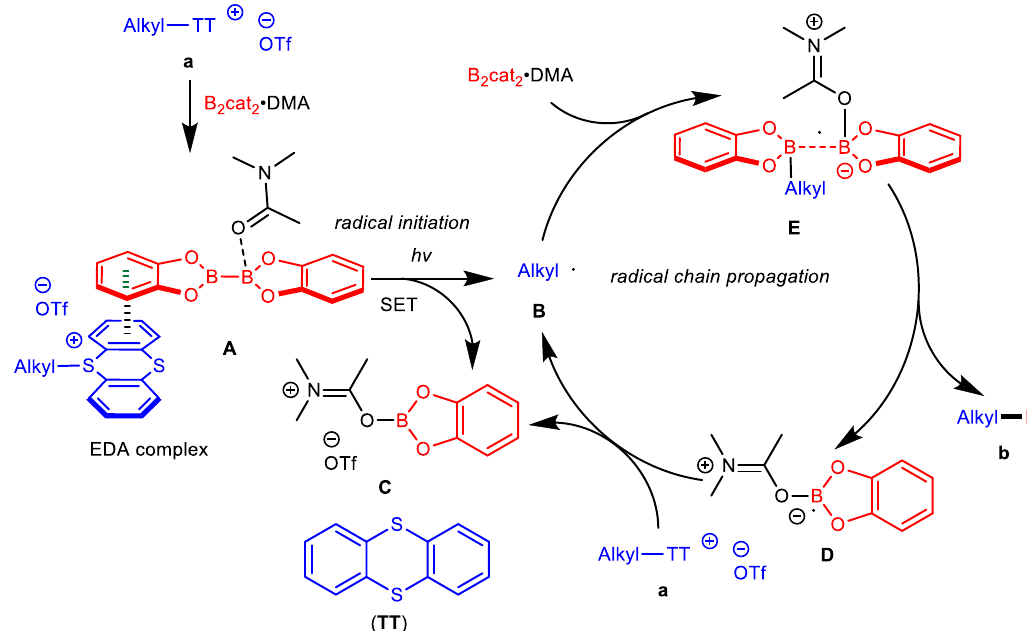
Fig. 7 Proposed mechanism. Possible reaction mechanism of of photoinduced desulfurative